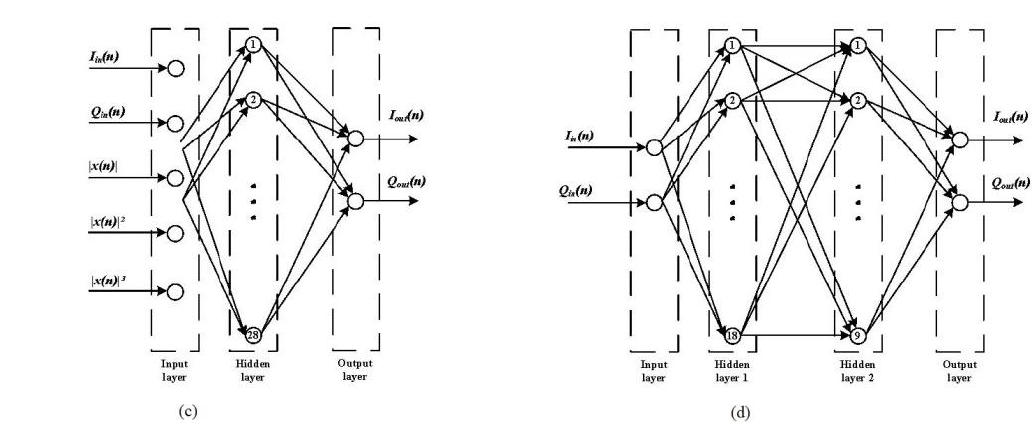
Figure 2. Block diagrams of the proposed NN models: ( a ) DNN, ( b ) RVTDNN, ( c ) ARVTDNN, ( d ) RVTDNN2L. Table 1. Performance and complexity of different